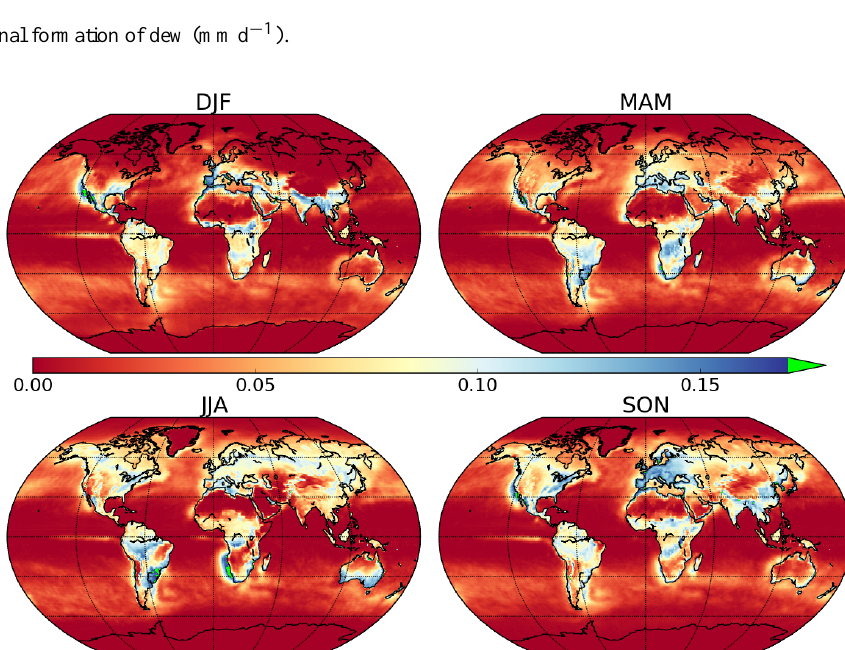
Figure 7. Standard deviation of the seasonal formation of dew (mmd − 1